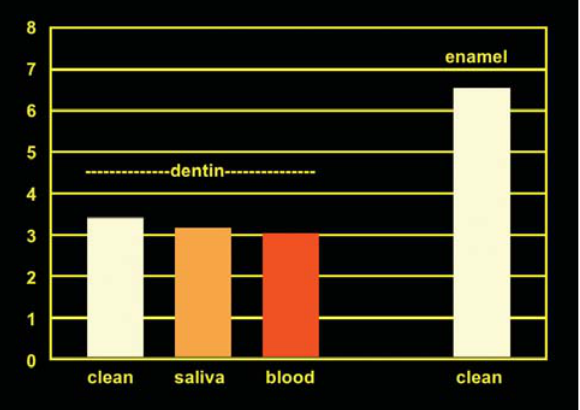
FIGURE 1- GIC bond strength [MPa] to contaminated substrates